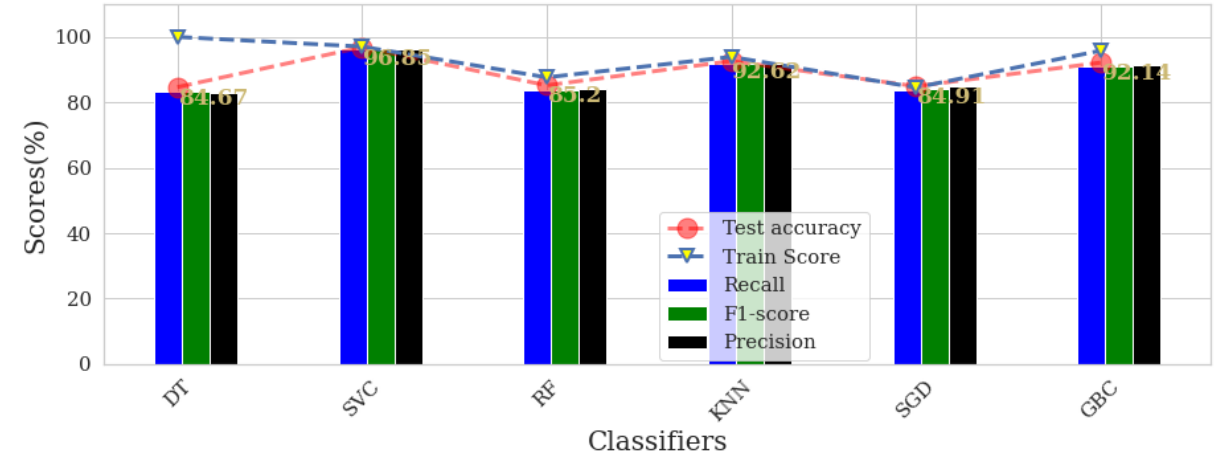
Figure 13. A global performance assessment plot of each classifier’s output on the test data.